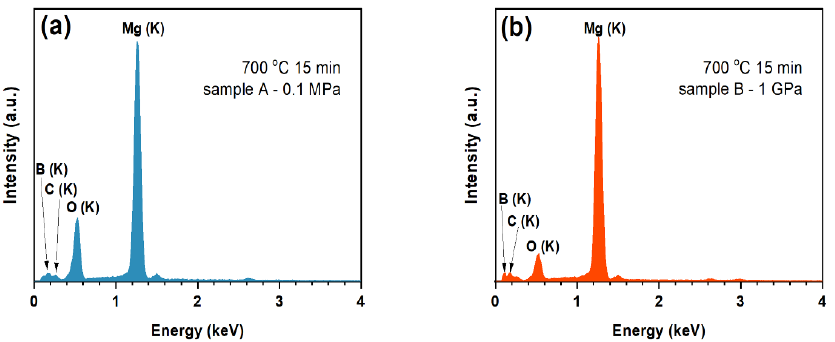
Figure 1. The EDS analysis of samples longitudinal-section for ( a ) sample A—0.1 MPa and ( b ) sample B—1 GPa.